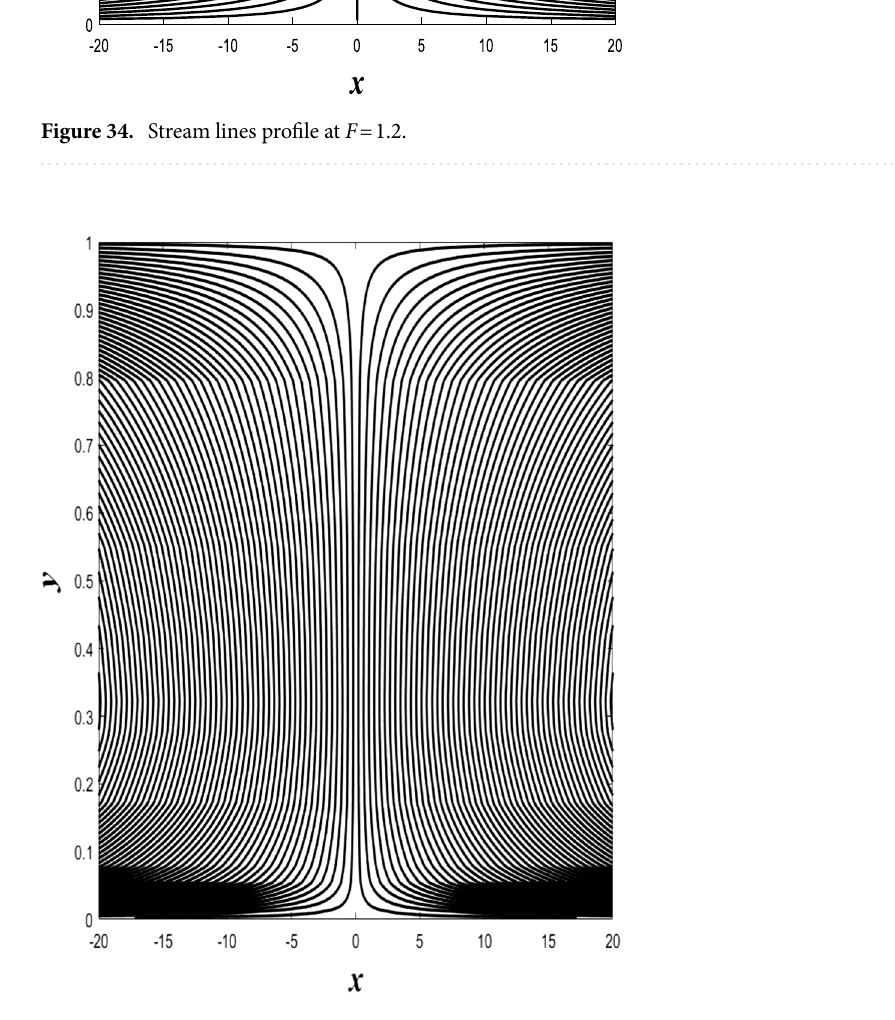
Figure 35. Stream lines profile at F =